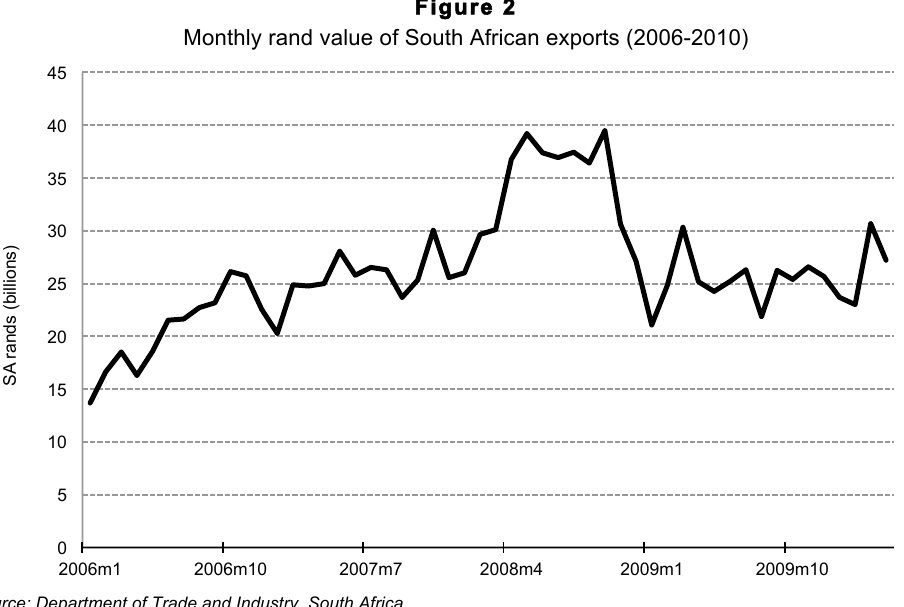
Monthly rand value of South African exports